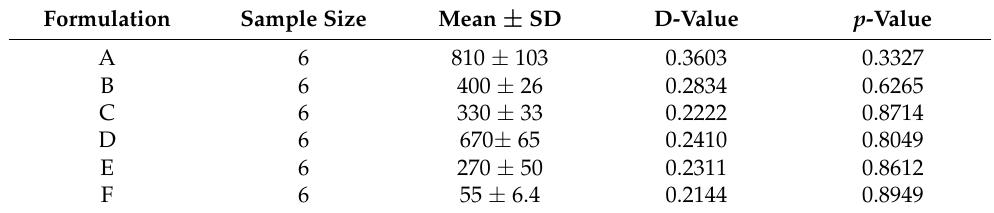
Table 4. Results of the K–S test of normality performed on capsase-3 enzyme data of all formulations.